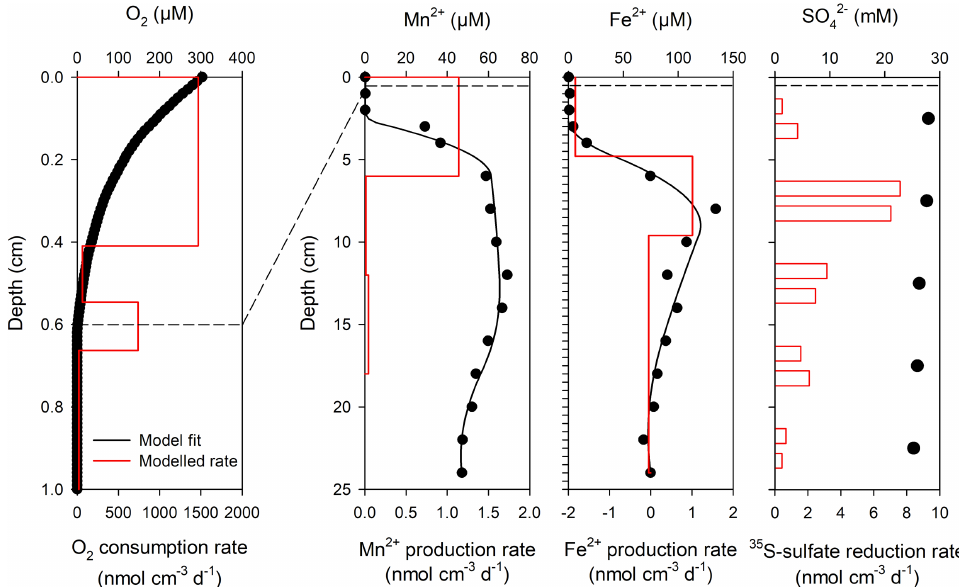
Figure 6. Comparison of reaction rates of oxygen, manganese, iron, and sulfate reduction at Station 23. Note the different depth scale for the O 2 consumption rate. The dashed line marks the oxygen penetration